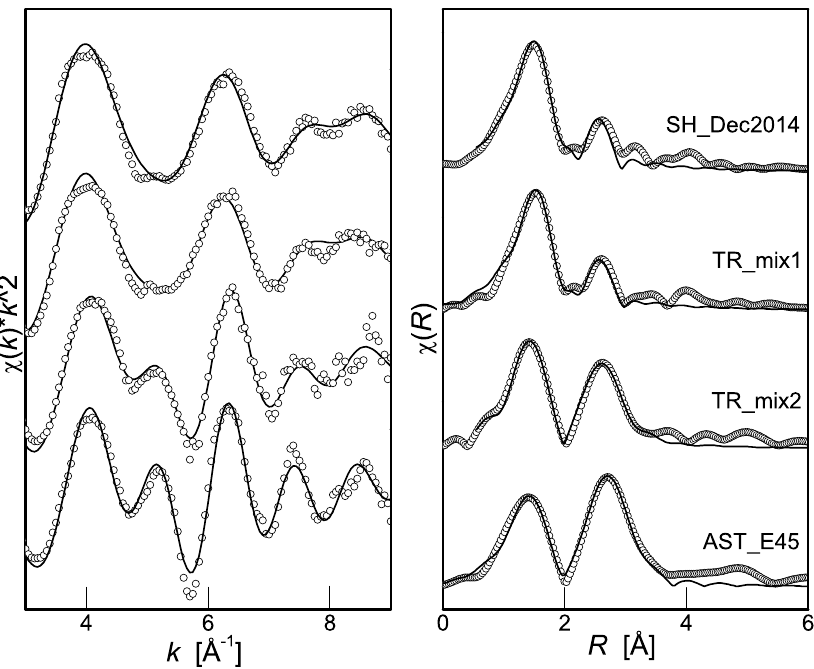
Figure 2. ( Lefthand panel ) k 2 weighted EXAFS spectra and ( Righthand panel ) the related Fourier transforms for Saharan dust (SH_Dec2014), steel production fumes (AST_E45) and mixed aerosol samples collected in the Terni urban area (TR_mix1 and TR_mix2). The open circles are the experimental data and the continuous lines the model best fits.